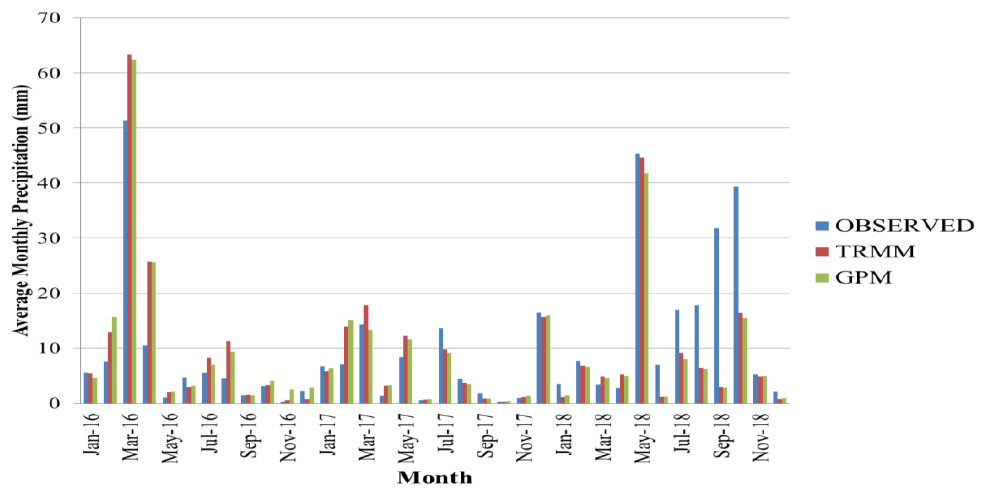
Figure 4. Monthly averages of precipitation estimates from NCSI (OBSERVED, (blue)), Global Precipitation Measurement (GPM) (green), and Tropical Rainfall Measuring Mission (TRMM) (red)) in Oman (2016 – 2018).